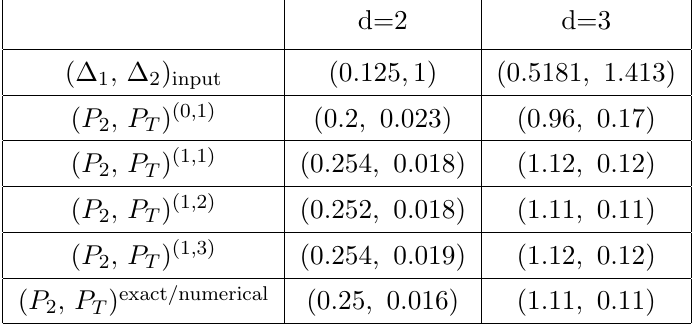
Table 7 . The estimates of the Ising OPE coe(cid:14)cient P 2 ; P T in 2d and 3d, the 2d exact values [104] and the 3d numerical bootstrap values [53]. We only show three signi(cid:12)cant (cid:12)gures of P 2 and two signi(cid:12)cant (cid:12)gures of P T . The zeroth order equations are (4.10) and the (cid:12)rst order equations are (4.13), (4.14), (4.15). The (cid:12)rst order estimates for the OPE coe(cid:14)cients of the 3d Ising CFT are rather